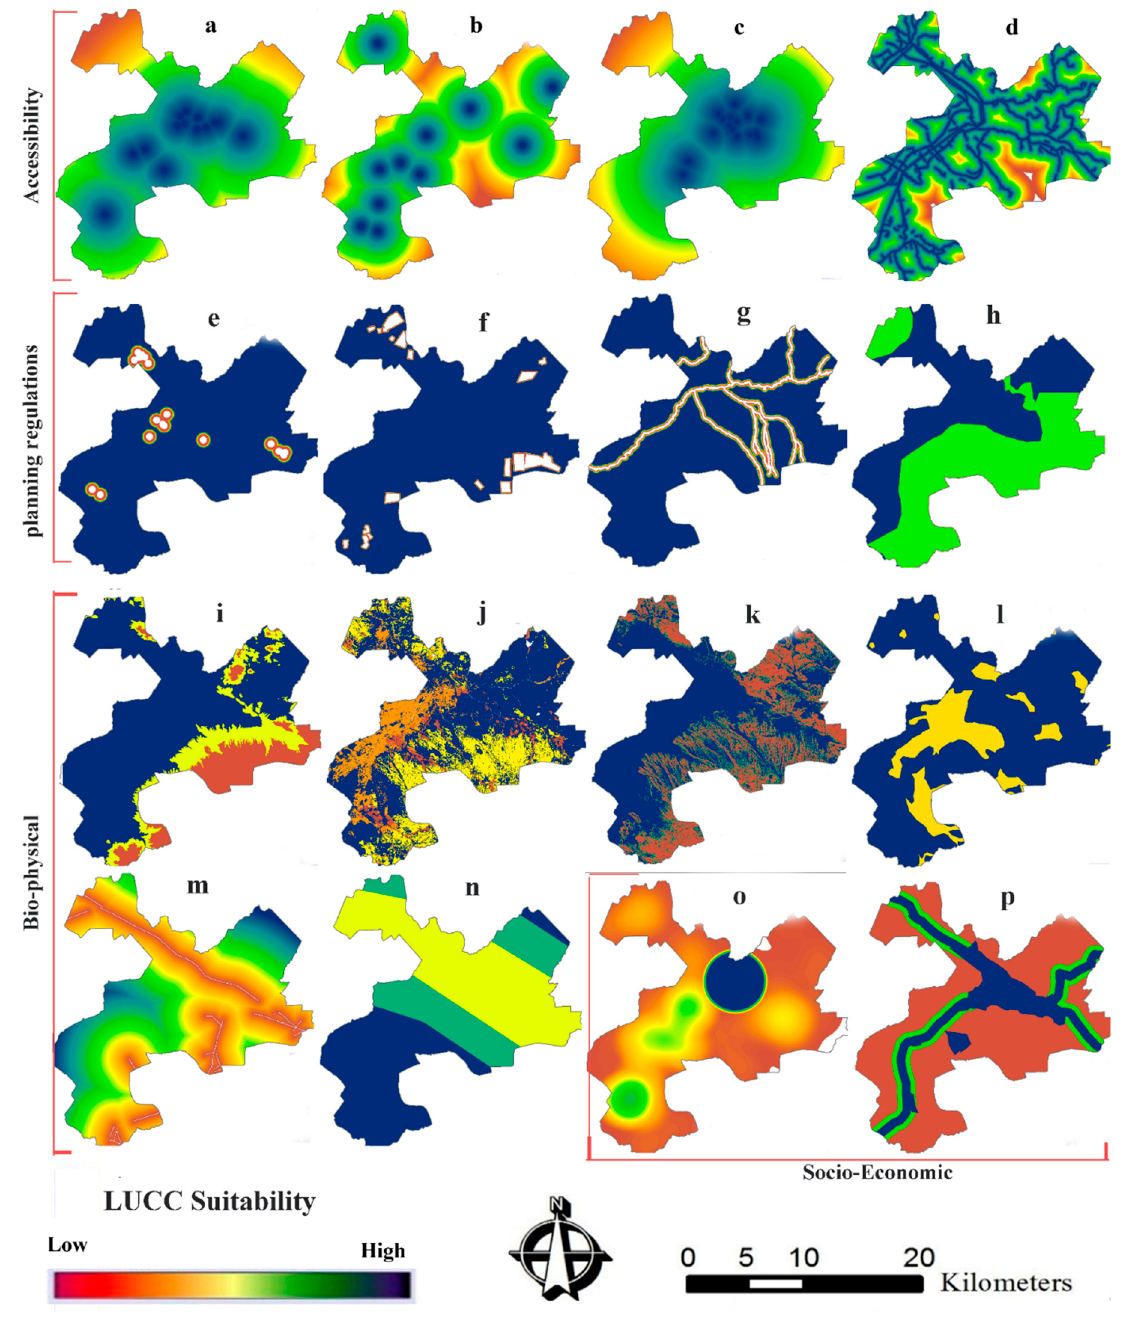
Figure 3. LUCC suitability analysis of driving forces due to urbanisation: ( a ) access to educational centres, ( b ) access to major cities, ( c ) access to entertainment centres, ( d ) access to the transport network, ( e ) industrial buffer zone, ( f ) existing mines, ( g ) rivers, ( h ) ecologically protected lands, ( i ) slope, ( j ) land cover, ( k ) elevation, ( l ) flood, ( m ) fault, ( n ) earthquake, ( o ) population density, ( p ) land price.